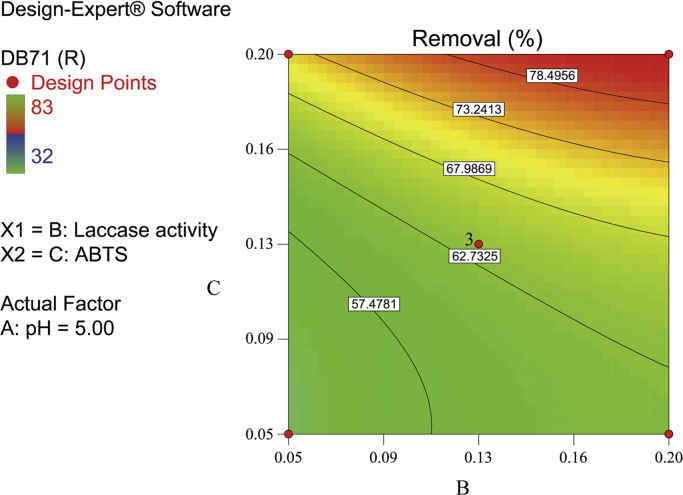
Contour plot of the interaction effects of laccase dose (B) and ABTS dose (C) on DB71 removal.